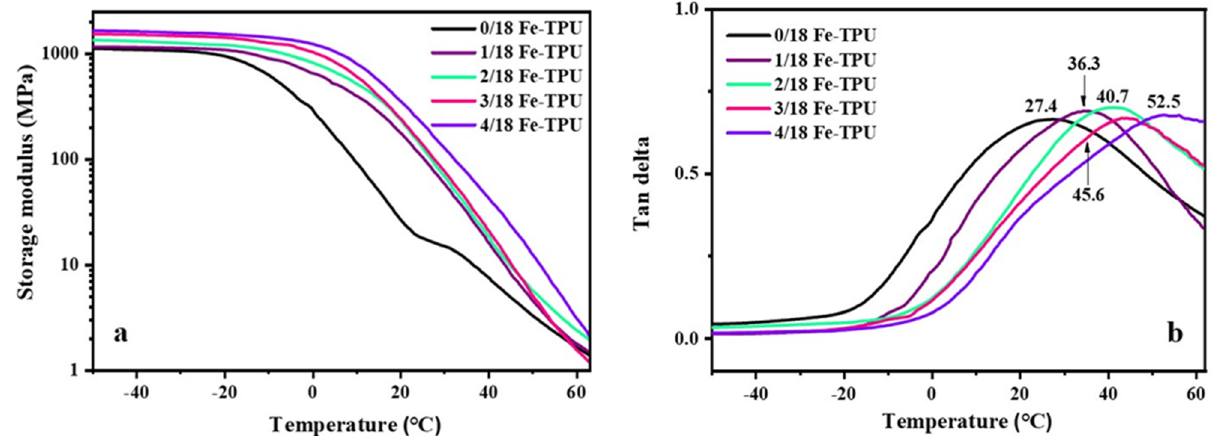
Figure 7. ( a ) Storage modulus, ( b ) tan delta of TPU reinforced with FeCl 3 .